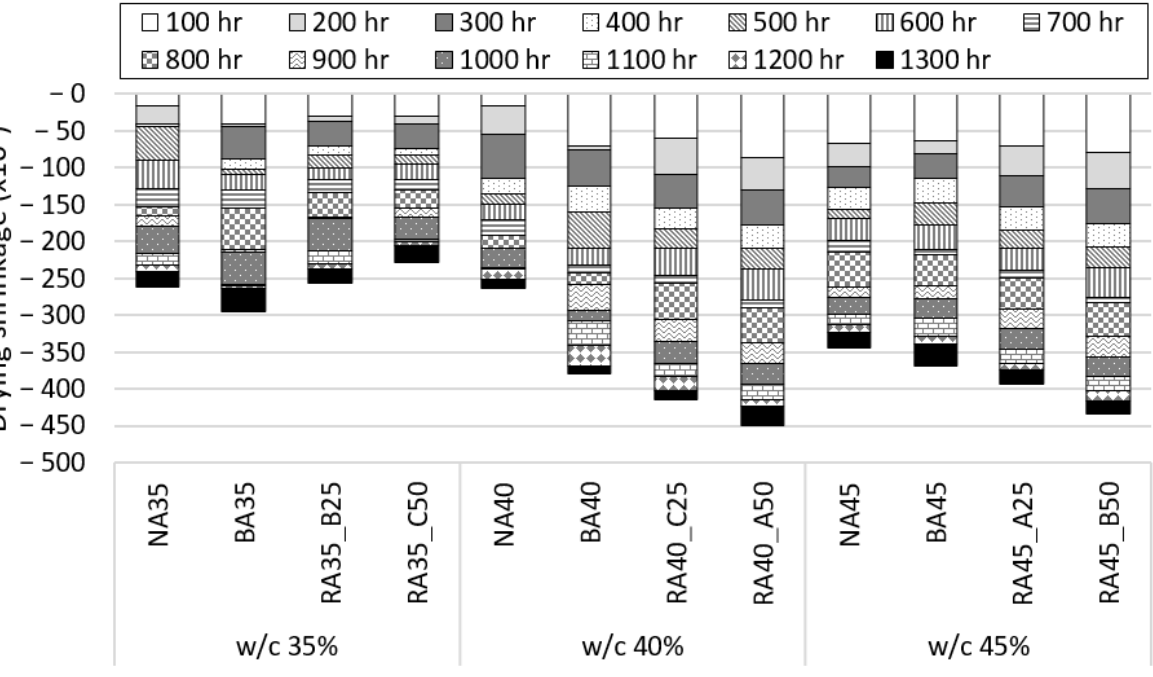
Figure 10. Drying shrinkage of concrete specimens according to water–cement (w/c) ratio.